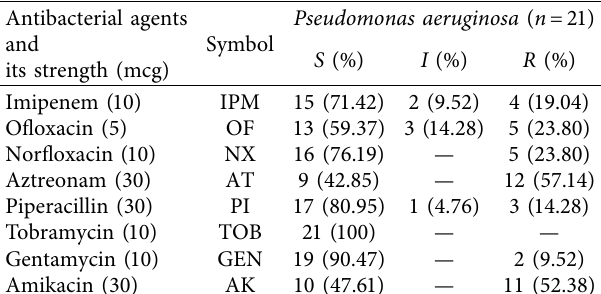
Table 5: Antimicrobial susceptibility profles of Pseudomonas aeruginosa at the Wolaita Sodo University wastewater treatment plant. Antibacterial agents and its strength (mcg)